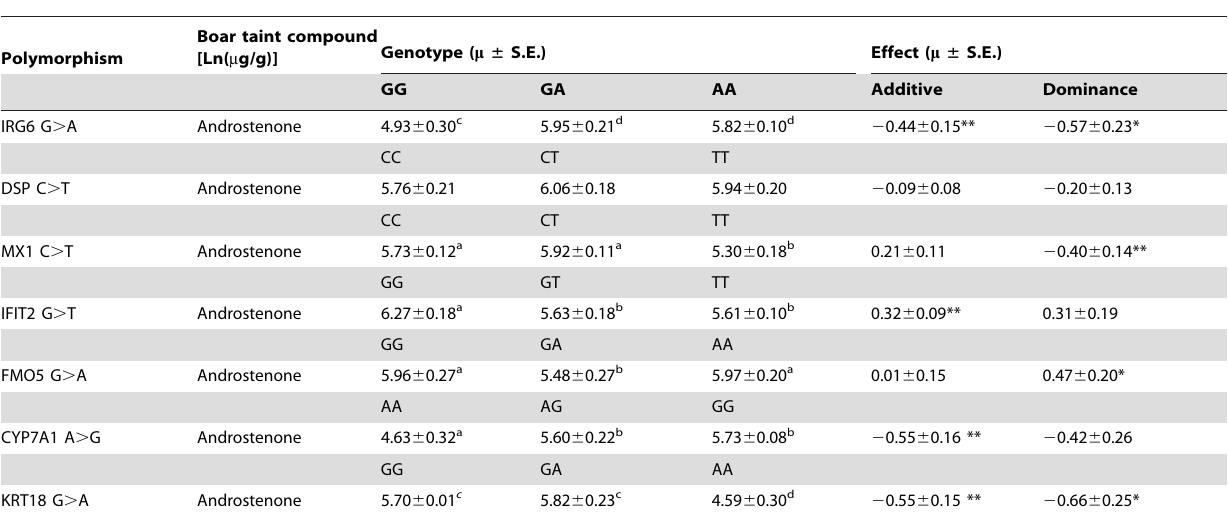
Table 9. Genotype and association analysis of selected candidate genes with androstenone.